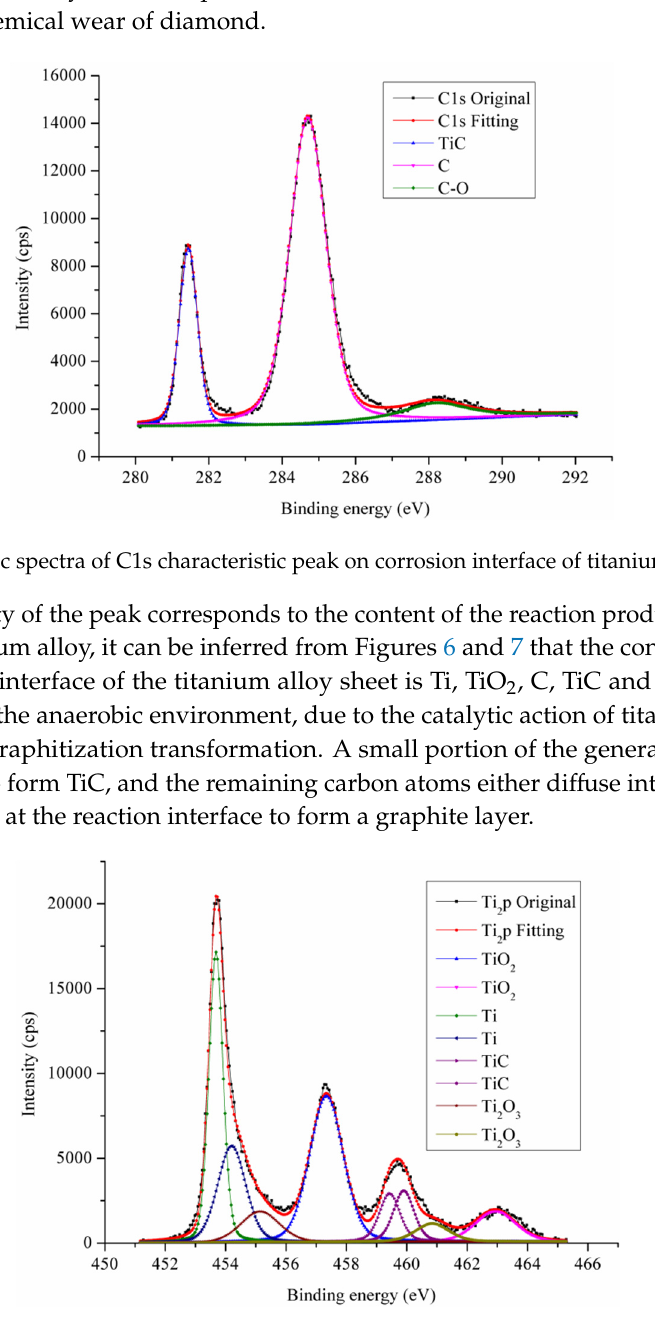
Figure 7. Electronic spectra of Ti 2 p characteristic peak on corrosion interface of titanium alloy in argon.